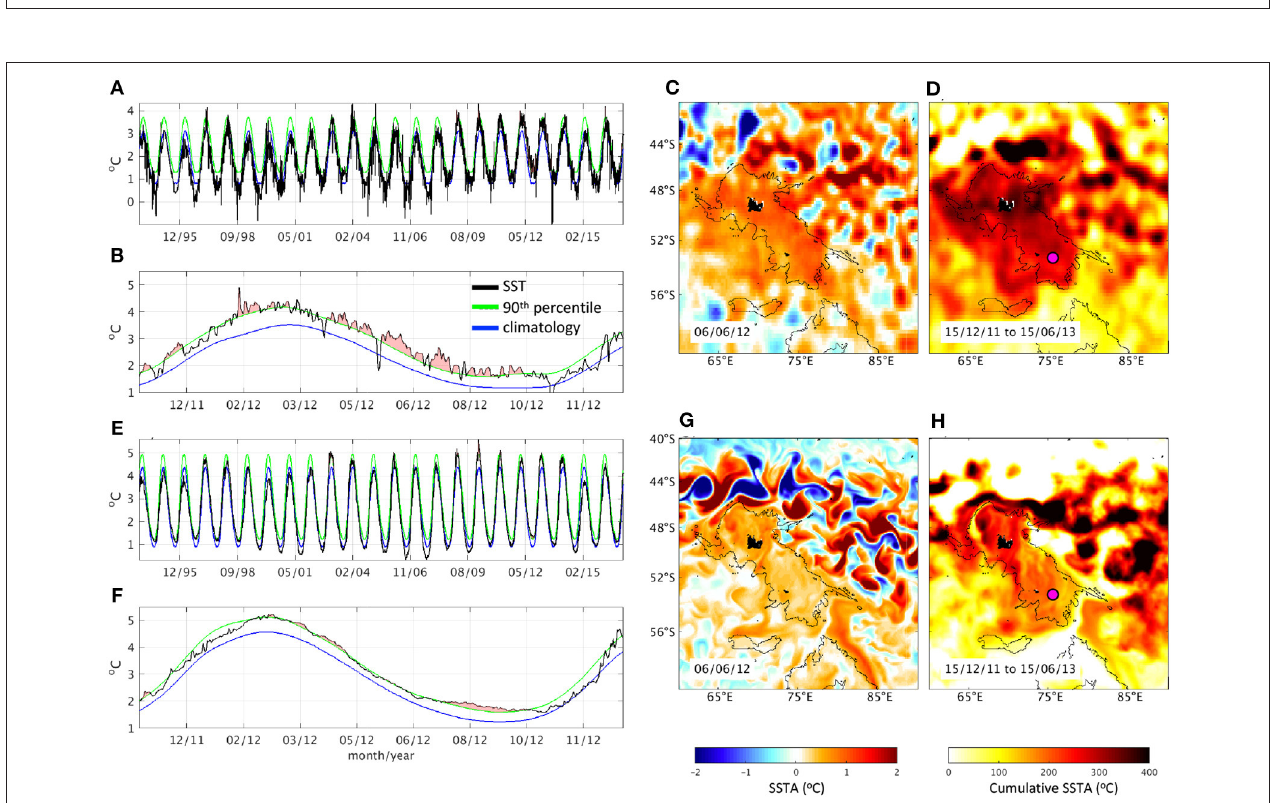
FIGURE 4 | (A) Time-series of SST (black), climatology (blue) and 90th percentile (green) in NOAA-OI observation-based product for 1994–2016 in the magenta dot shown in (D) ; (B) as in (A) but for November 2011 to December 2012; (C) SSTA snapshot of July 2012 in NOAA-OI; and (D) cumulative SSTA of December 2011 to July 2013 in NOAA-OI; (E–H) as in (A–D) , but for OFAM. Black contours are the 3,000 m isobath.